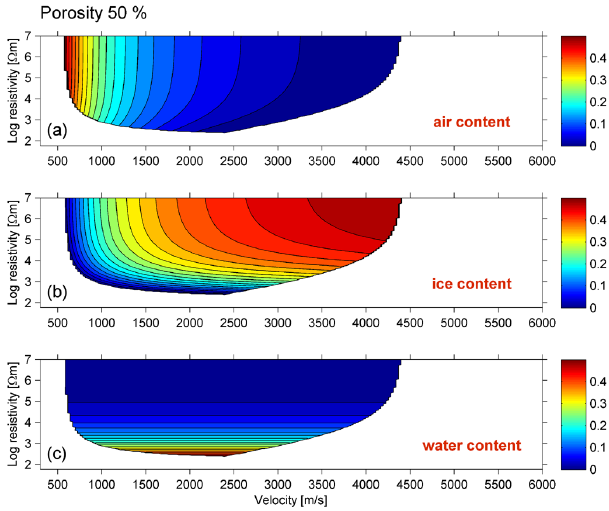
Fig. 1. Volumetric fractions of (a) air, (b) ice and (c) water within the pore spaces as a function of electrical resistivity and seismic P-wave velocity for a porosity of 50% and a set of material prop- erties corresponding to the debris-ice-rock mixture often found at mountain permafrost sites (Table 1).